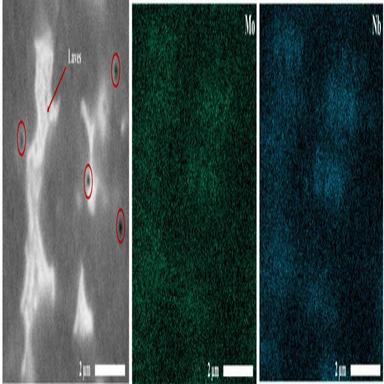
SEM-EDS images showing the submicron scaled dark contrast carbide precipitates and Laves phases with elemental segregation of Nb and Mo. (For interpretation of the references to colour in this figure, the reader is referred to the web version of this article.)